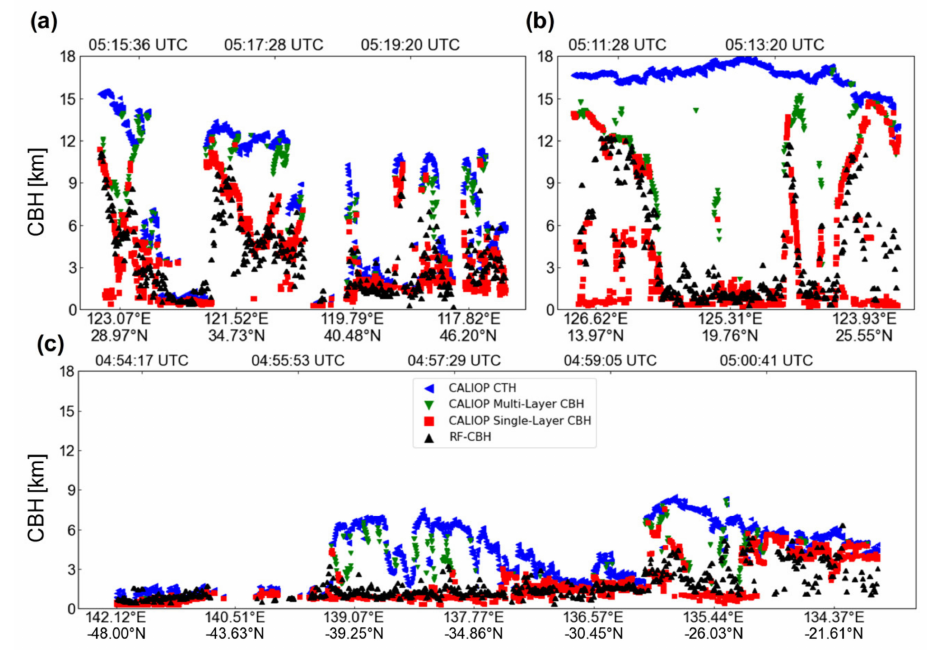
Figure 5. The cross sections along CALIOP scanning tracks for Super Typhoon Meranti and low/high cloud case study: ( a – c ) The cross sections refer to the orange dot lines in Figure 4b–d. The black upward triangle markers represent CBH estimates, and the red square, green downward triangle, and blue leftward triangle markers are the CBH of the lowest clouds, the CBH of the topmost clouds, and the CTH of the topmost clouds from CALIOP observations, respectively. Note that the lowest cloud can be either single- or multilayered, and the green downward triangle markers only exist in multilayer clouds.